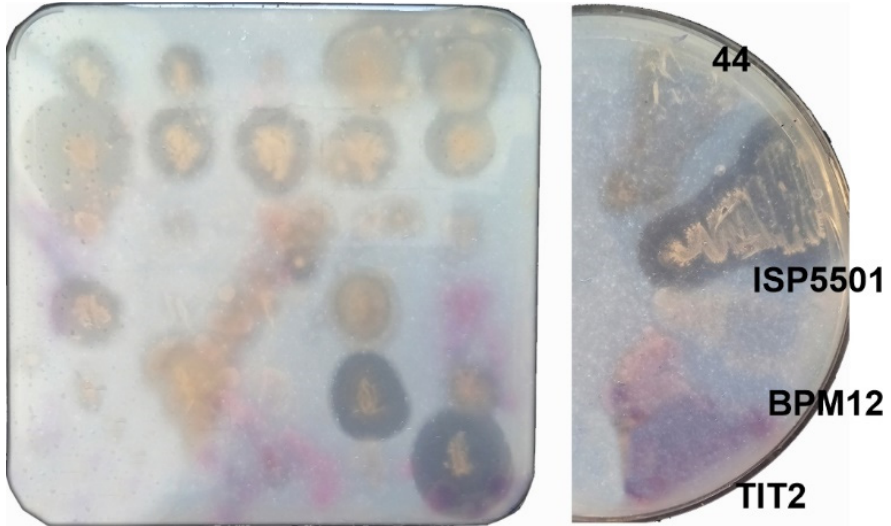
Figure 3. Pre-screening of bacterial strains on Impranil-containing agar plates. Based on the clearing zone, four bacterial strains ( Pseudomonas sp. (44), Amycolatopsis mediterranei (ISP5501), Bacillus sp. (BPM12), and Streptomyces sp. (TIT2)) were selected for whole-cell biocatalytic reactions with PU-7. Possible degradation products were not easily observed using a standard HPLC approach, therefore UHPLC-MS screen of whole-cell biotransformation reactions afforded the detection of urethanase activity in a high-throughput manner and to differentiate cleaving activities of amidases/proteases and esterases. MS spectra of reactions were compared to PU model substrate control reactions containing no biocatalyst (Figure